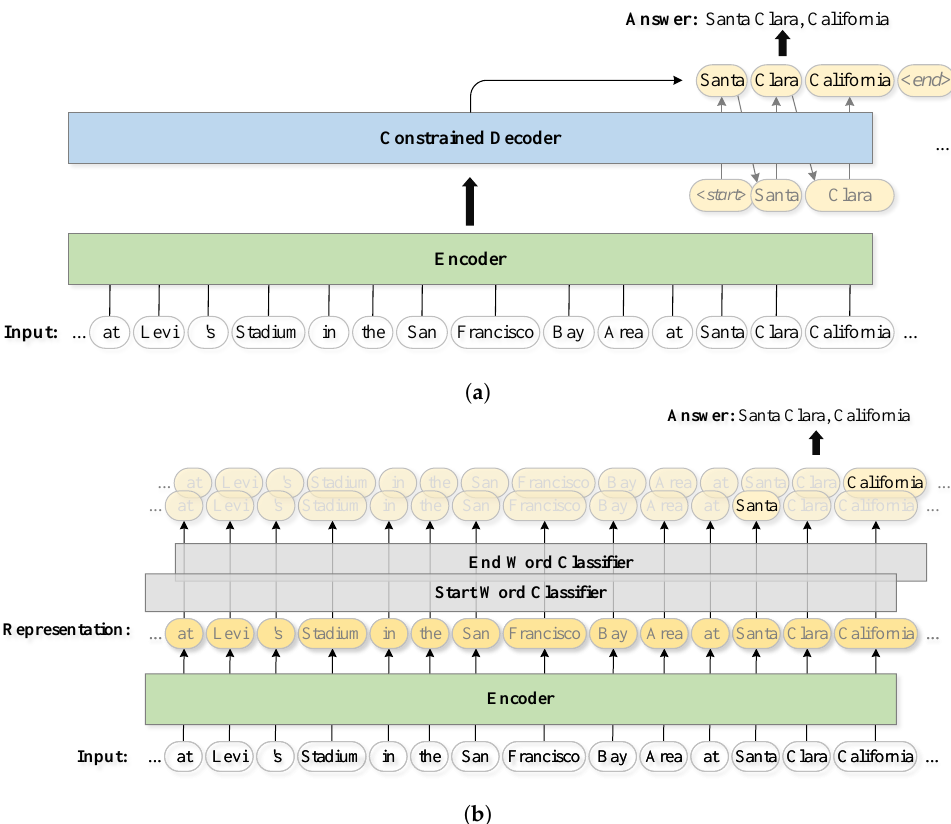
Figure 3. The comparison between the proposed model and a baseline model. The input question is “ Which NFL team represented the NFC at Super Bowl 50? ”. The answer is “ Santa Clara California ”. ( a ) The encoder-decoder model is used to solve the extractive QA task, taking advantage of all words in the answer. ( b ) The baseline extractive QA models use the start and end words